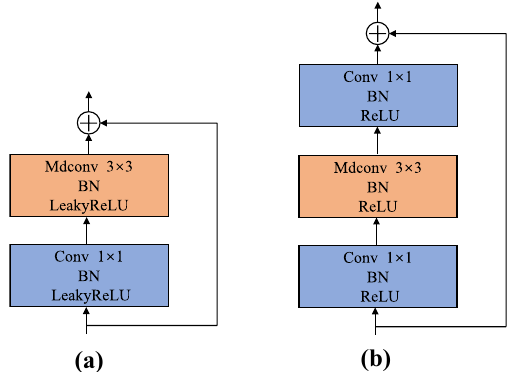
Fig. 4 The replaced building blocks: a is the building block embedded with Mdconv of the improved DarkNet-53; b is the building block embedded with Mdconv of the improved